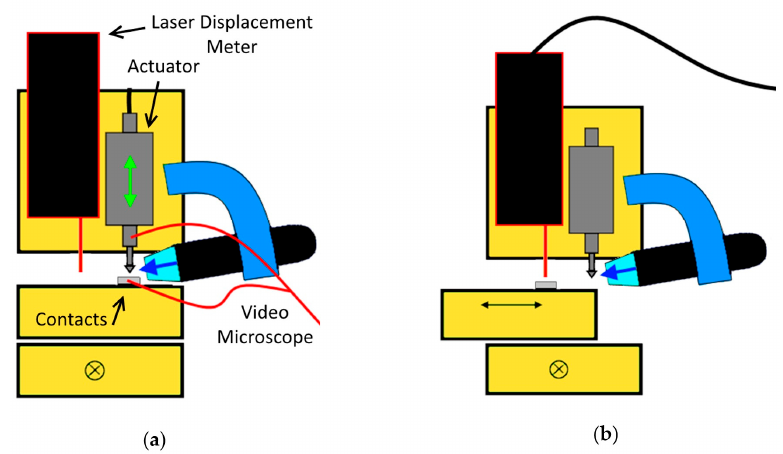
Figure 2. Schematic of In-site Surface Evolution (ICE) testing apparatus during ( a ) Switching Mode, where the piezo-electric actuator opens and closes the switch and ( b ) Surface measurement mode. Table 1. Summary of key specifications of the In-situ Contact Evolution (ICE) apparatus.